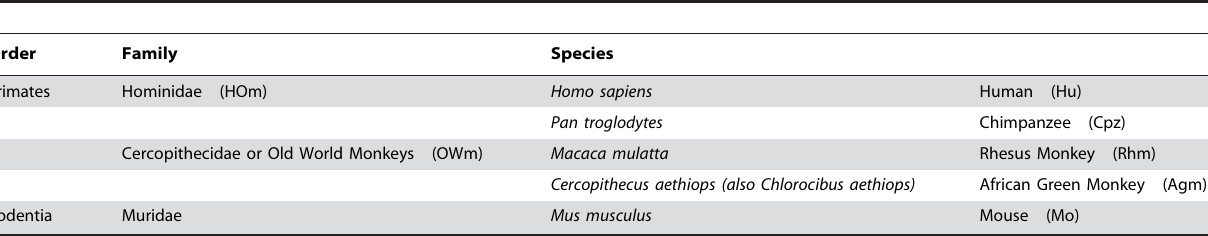
Table 1. Species classification of the various studied ISG15 orthologues with the relevant abbreviations.